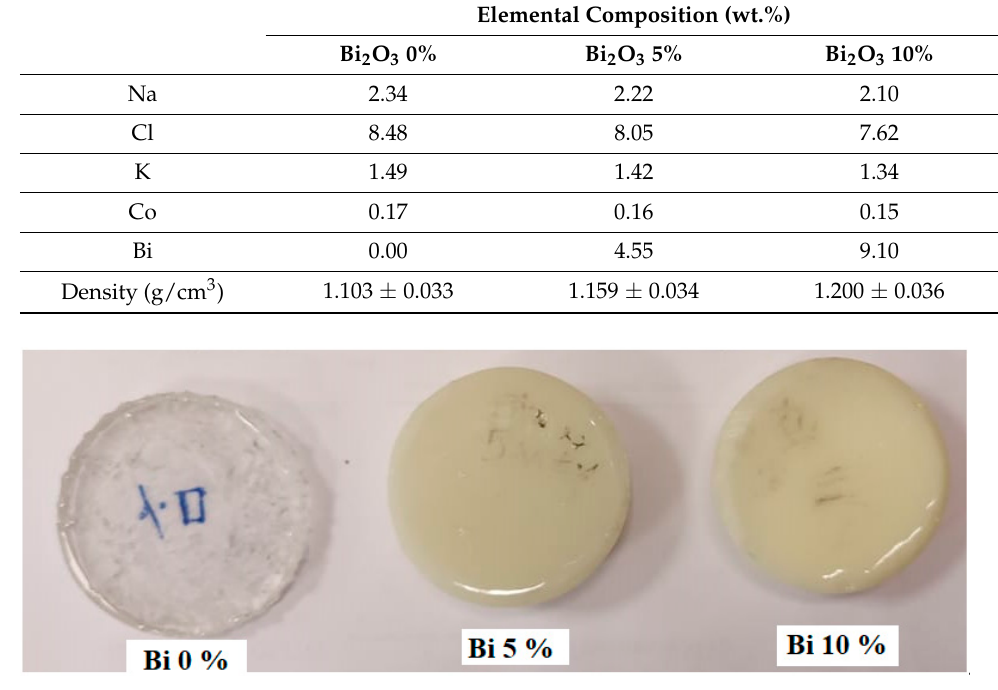
Figure 1. Fabricated polyepoxide-reinforced Bi 2 O 3 composites. Table 1. Elemental composition and density of the synthesized composites.